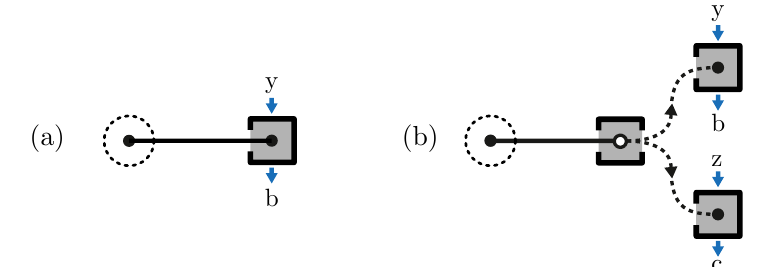
Figure 4: Illustration of a steering scenario where the measurements performed by Alice are trusted to be completely characterized (hence, represented by a